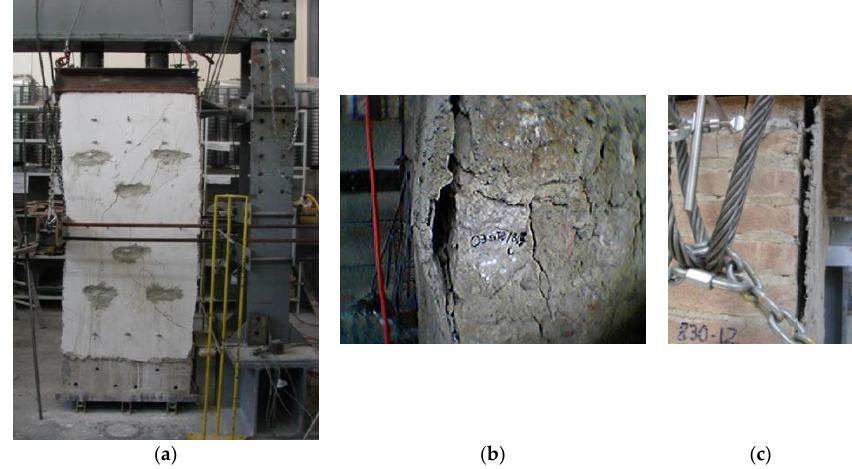
Figure 26. Typical failure mode of repaired wall panels: ( a ) stonework panel, ( b ) detail of the failure mode (stonework panel), ( c ) brickwork panel.